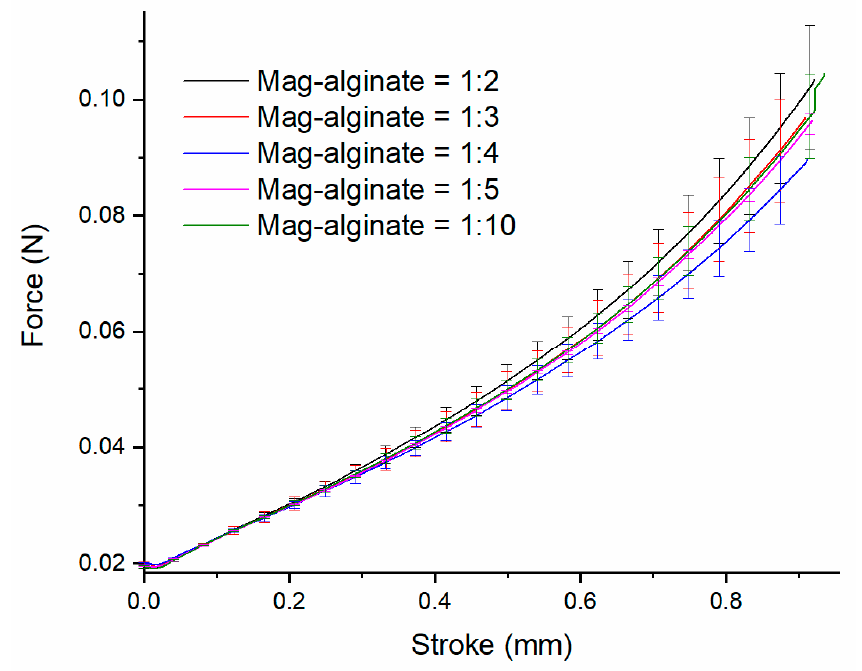
Figure 3. Compression tests of samples prepared with different ratio Mag–alginate (1:2, 1:3, 1:4, 1:5 and 1:10).